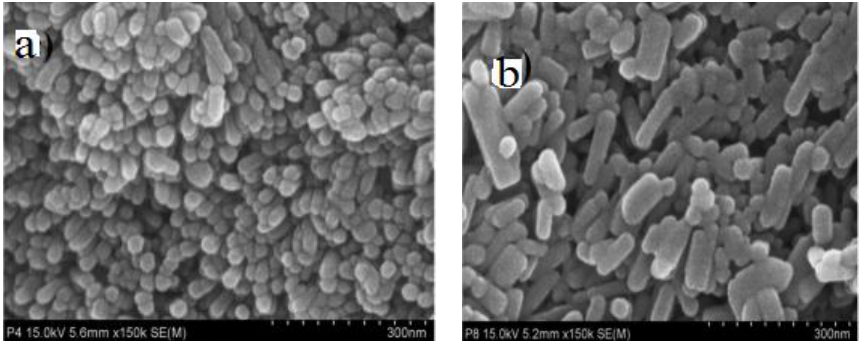
Figure 14. SEM images showing the morphologies of nZnO prepared from solvothermal process: ( a ) ZnO NPs in ethylene glycol for 3 h, and ( b ) ZnO nanorods in tetraethylene glycol for 3 h. Reproduced from [99] under the Creative Commons Attribution license.